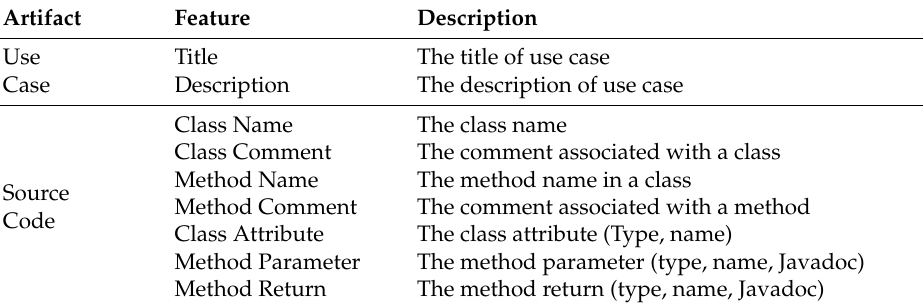
Table 1. The vital features of a traceability link vector in Phase